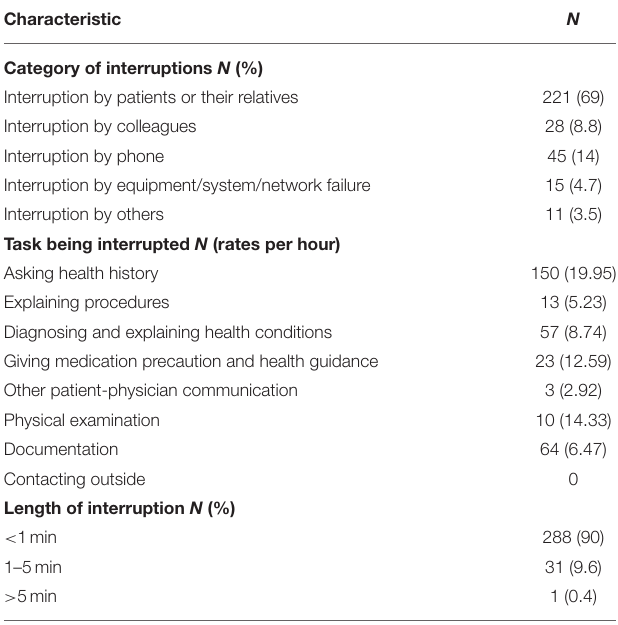
TABLE 2 | Sources of workflow interruption.